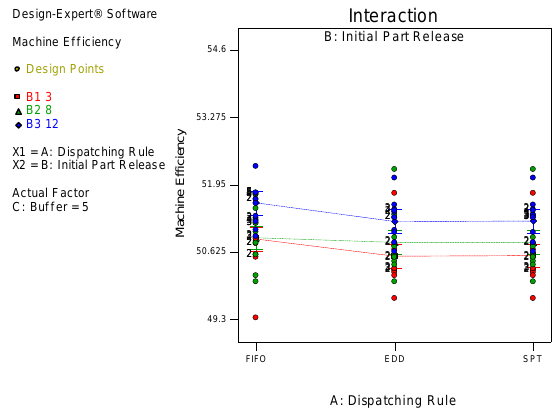
Figure 18. Machine efficiency initial part release & dispatching rule